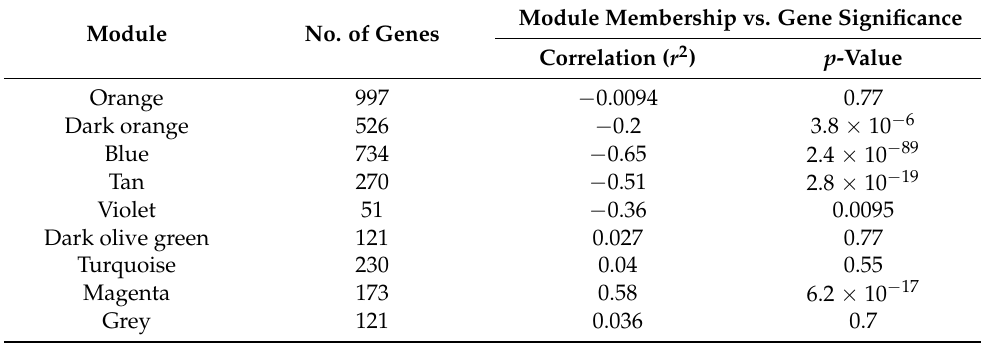
Figure 3. WGCNA of DEGs and antioxidant enzyme activity. ( a ) Cluster dendrogram presents nine co-expression modules labeled with different colors. ( b ) Correlation heatmap between DEGs and antioxidant enzyme activity. Rows correspond to modules. The color (from blue to red) indicates the correlation value (from − 1 to 1). Table 2. Correlations between module membership and gene significance of modules.